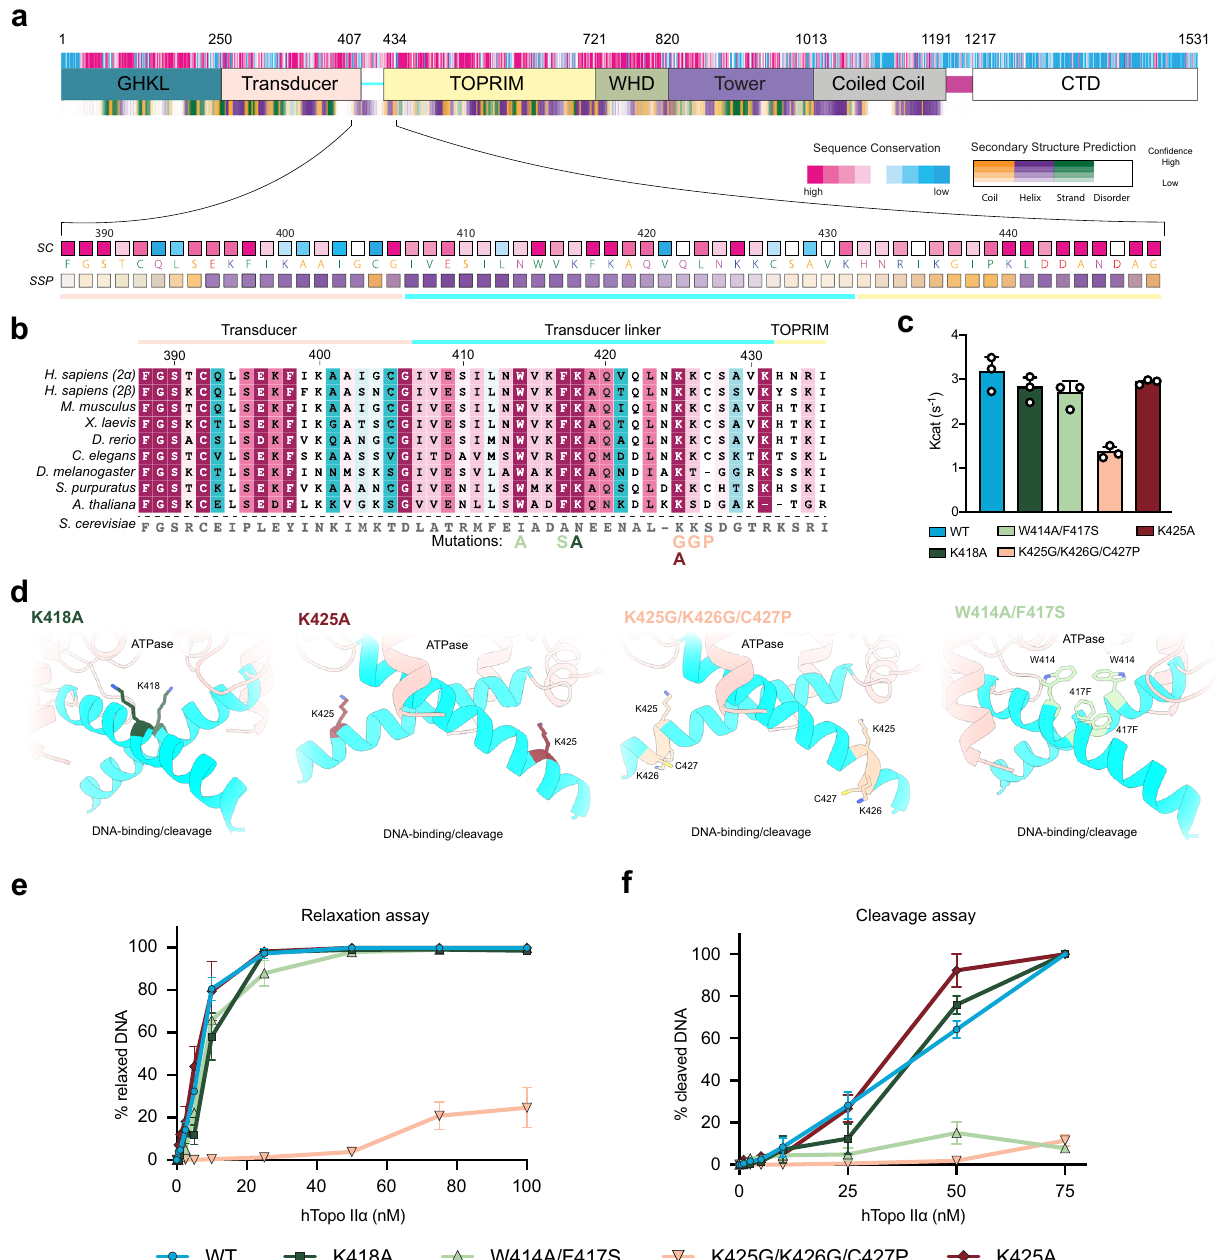
Fig. 4 Analysis of the hTopo II α allosteric regulation mediated by the linker connecting the N-gate to the DNA-gate. a Domain organization, sequence conservation, and secondary structure prediction for hTopo II α . Below is a zoom view of the linker joining N-gate to DNA-gate showing the sequence at a residue level. SC stands for sequence conservation. SSP stands for secondary structure prediction. b Multiple sequence alignment focused on the linker region. The yeast sequence is displayed as information but was not included in the conservation calculation. c ATP hydrolysis activity of the wild-type, K 418 A, W 414 A-F 417 S and K 425 G-K 426 G-C 427 P and K 425 hTopo II α . Kcat values are presented as mean values ± standard error (SE) for three independent replicates ( n = 3). Individual data points are also plotted. d Spatial localization of the mutated residues on the linker joining N-gate to DNA-gate. e Relaxation and cleavage f activities for the wild-type, K 418 A, W 414 A-F 417 S, K 425 G-K 426 G-C 427 P and K 425 A hTopo II α . Zoomed panels on the region 0 – 10 nM is available in Supplementary Fig. 9. Data are presented as mean values ± SE for three independent replicates ( n = 3). The source data for panels c , e , and f are provided as a Source Data fi